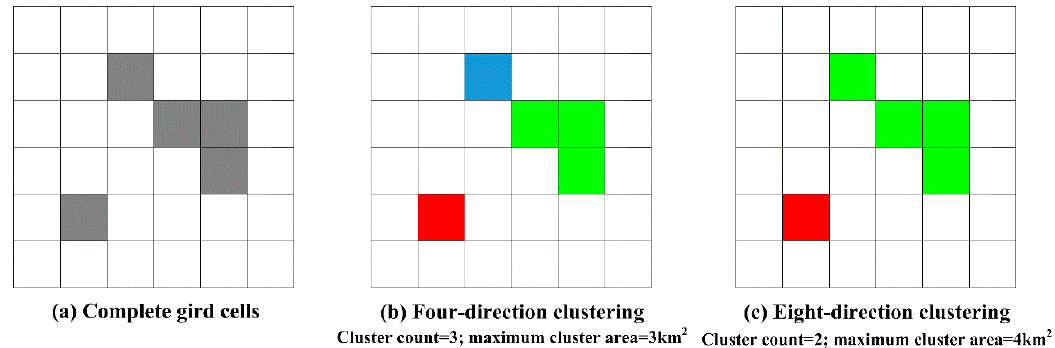
Figure 1. ( a – c ) Illustration of the clustering approach for analyzing spatial patterns of high-density grid cells .